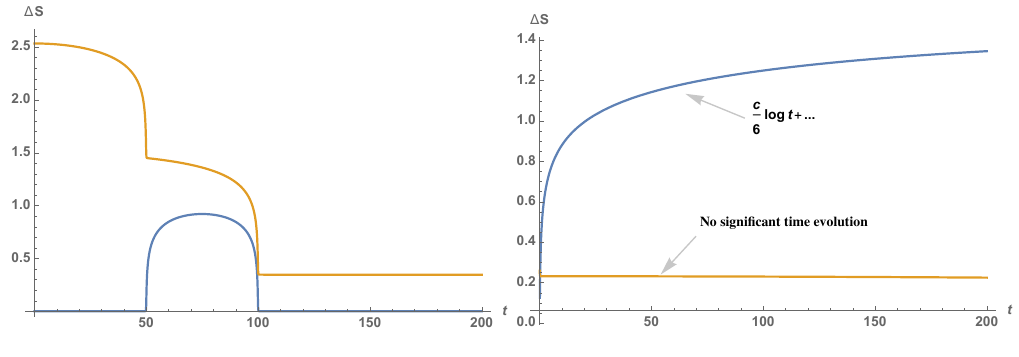
Figure 7 . ∆ S con = S con S (0) (blue lines) and ∆ S dis = S dis S (0) (orange lines) after a single A A − A A − A A is the EE of the vacuum state. A = [50 , 100] in splitting quench in a holographic CFT, where S (0) A the left figure and A = [0 . 1 , 1000] in the right figure. We set a = 0 . 1 and c = 1. The boundary entropy S bdy is set to be